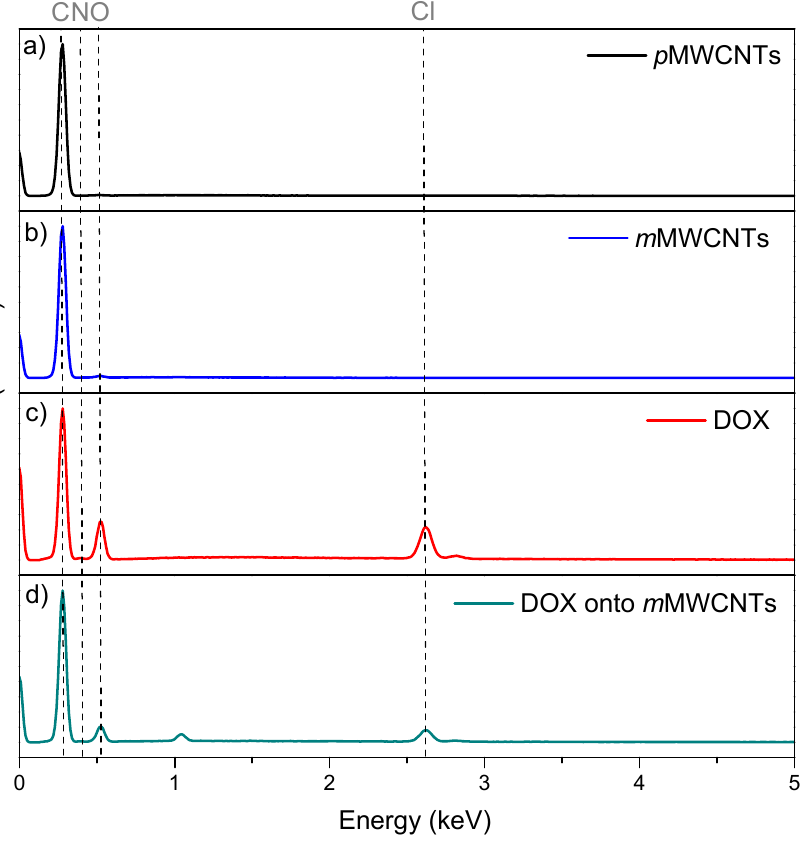
Figure 4. EDS spectra of p MWCNTs ( a ), m MWCNTs ( b ) doxorubicin ( c ) and doxorubicin adsorbed onto m MWCNTs ( d ).